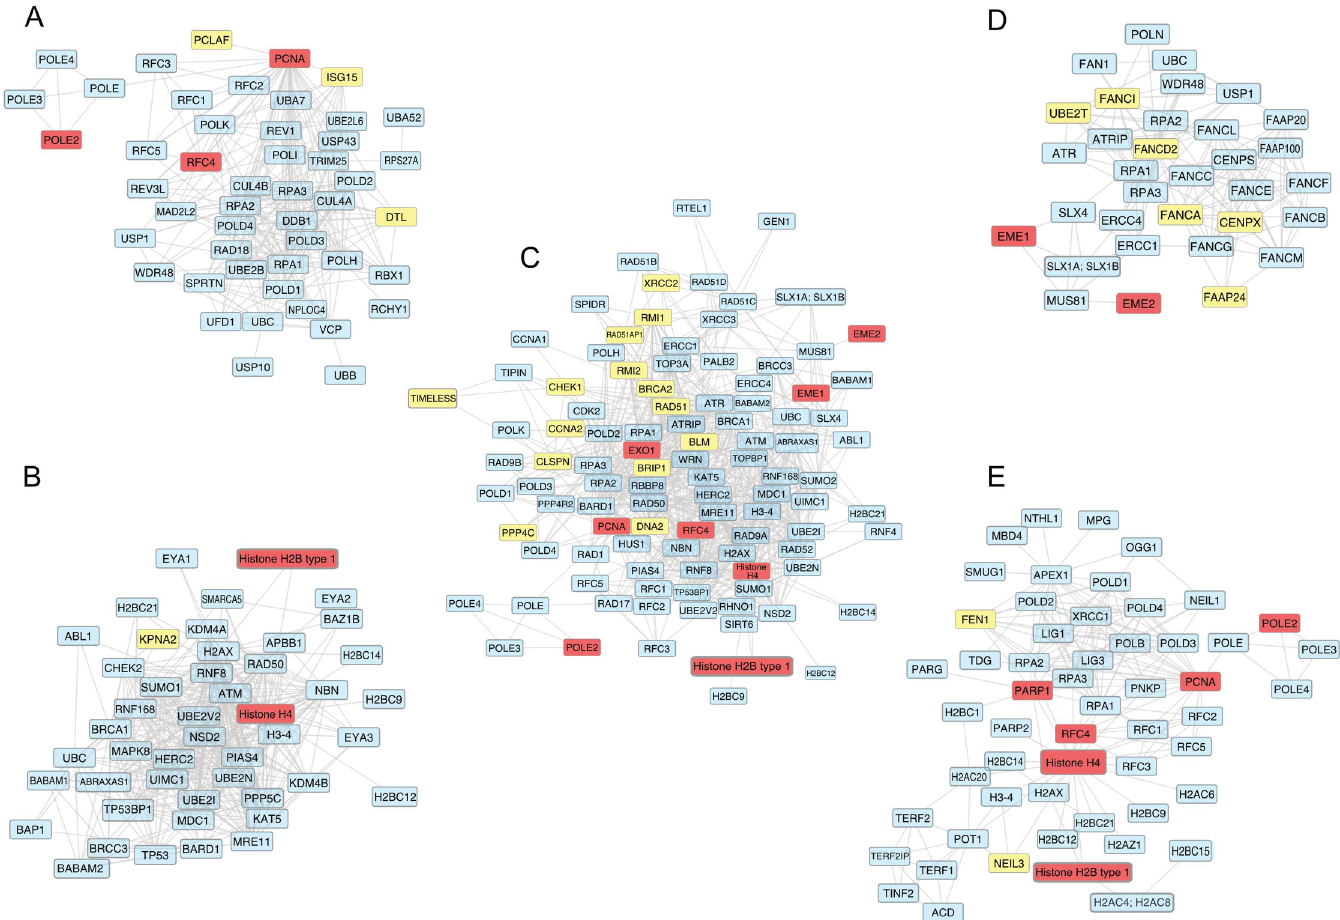
Fig 2. Protein-protein interaction networks of five repair pathways . A) DNA bypass B) DNA DSB response C) HDR D) FA E) BER. Overexpressed genes are highlighted in red and yellow. Red indicates that the genes function in other repair pathways besides the pathway indicated. Grey edges represent protein-protein interactions.